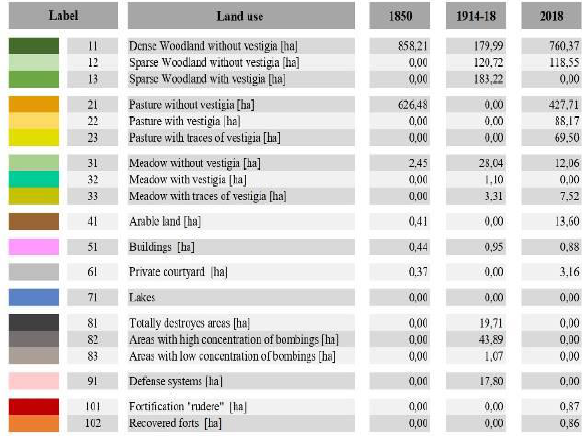
Figure 6 . Table land use categorizations and quantitative summary of LCLU in the three time frames of study